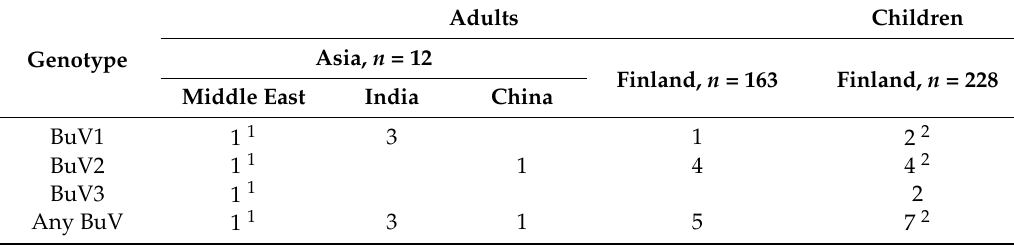
Table 2. BuV IgG-positive adults and children. The origins of the subjects are shown in the header.